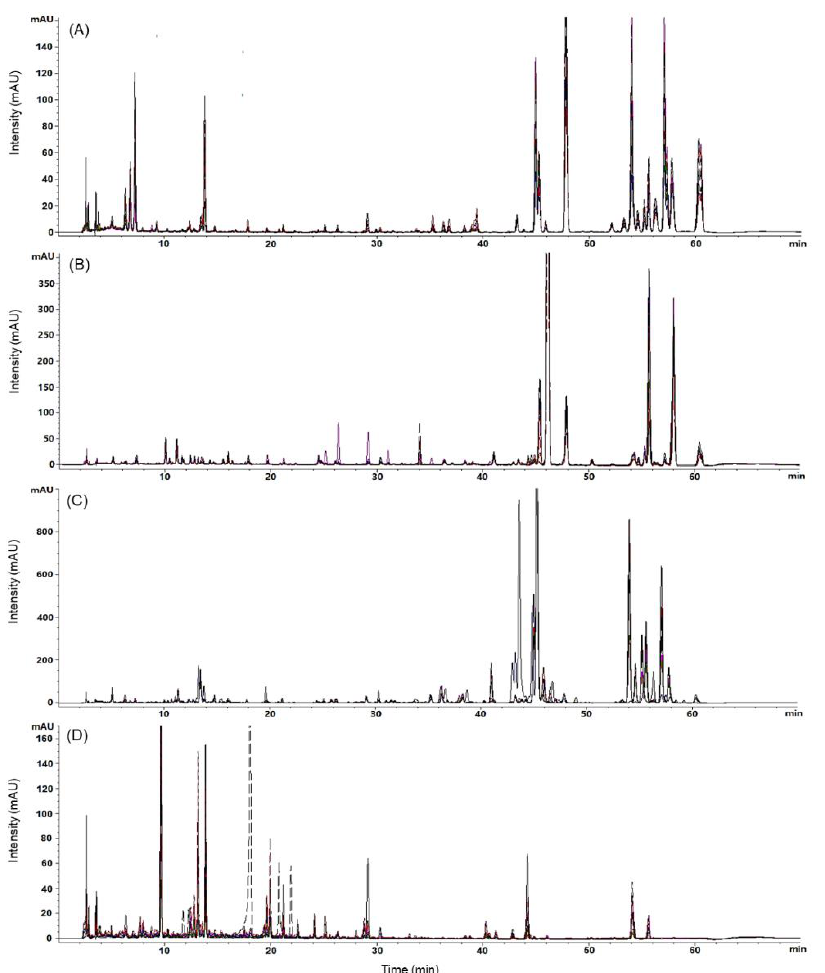
Figure 2. Overlapping chromatograms of representative samples of Peucedanum japonicum (( A ) PJ01 – 10), P. praeruptorum (( B ) PP01 – 10), Angelica decursiva (( C ) AD01 – 07), and Saposhnikovia divaricata (( D ) SD01 – 10) at a detection wavelength of 325 nm.